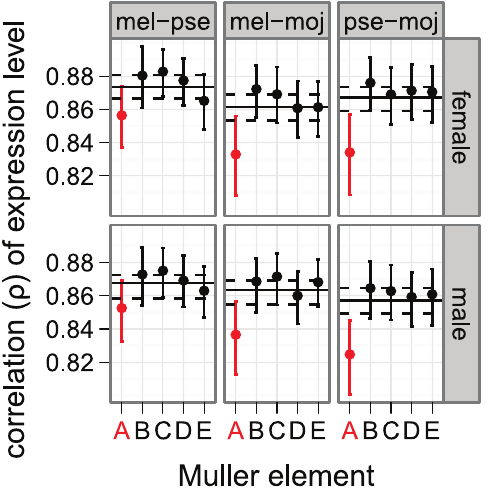
Figure 2. Faster-X evolution of gene expression measured in head. Gene expression measurements from head using microarrays were used to calculate the correlation of expression levels between D. melanogaster (mel), D. pseudoobscura (pse), and D. mojavensis (moj). Expression was measured in females (top) and males (bottom). Graphs are the same as in Figure 1.